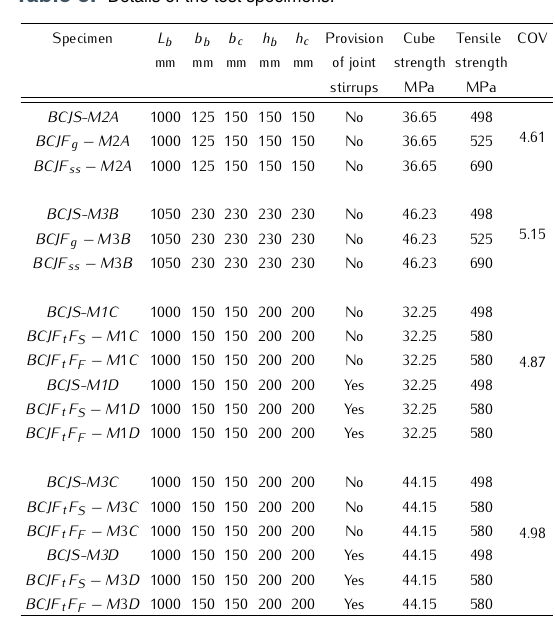
Table 3. Details of the test